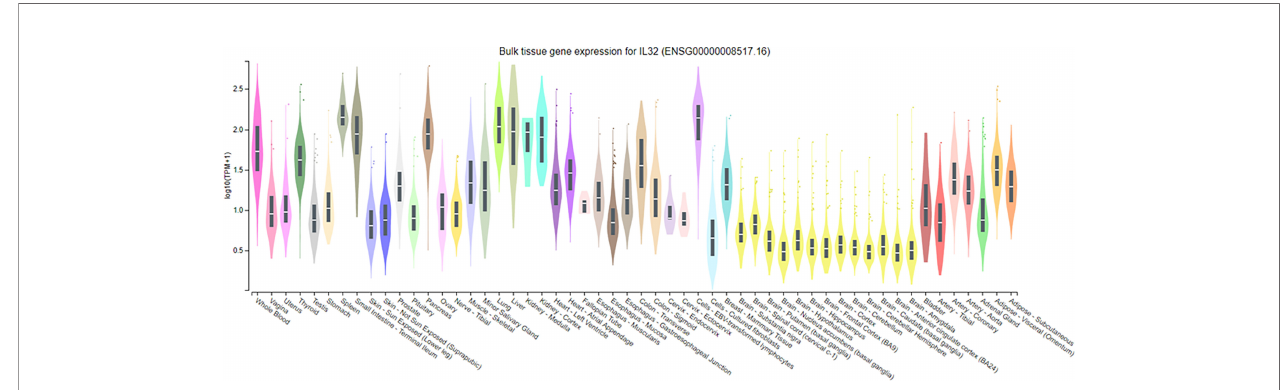
FIGURE 3 | Expression of IL-32 in normal tissue samples. IL-32 gene expression analysis on normal tissue using GTEx portal; values of expression are shown in transcript per million and are calculated from a gene model with the isoforms collapsed to a single gene. The box plots are shown as median and 25th and 75th percentiles; the outliers are de fi ned as above or below 1.5 times the interquartile range and are shown as points. The highest IL-32 expression was found in the spleen, followed by Epstein – Barr virus-transformed lymphocytes, and lung, whereas the lowest was observed in all tissue types of